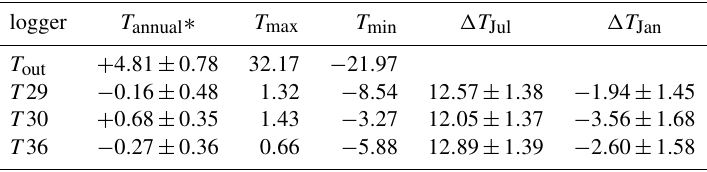
Figure 2. Air temperature measured at T29 (Eisdom) in blue and next to the cave entrance (grey). Green markers indicate periods when the daily mean potential temperature outside falls below that at T29; orange markers indicate days when the daily standard deviation at T29 exceeds 0.1 ◦ C. The numbers next to the markers indicate the number of days the respective criteria were met for each year. The dashed red line marks the 0 ◦ C line. Table 1. Average climatological parameters outside HIC as well as at the three main monitoring sites inside the cave (2009–2020). All temperatures are given in degrees Celsius. (cid:49)T is the mean temperature difference between outside and the respective location inside the cave.